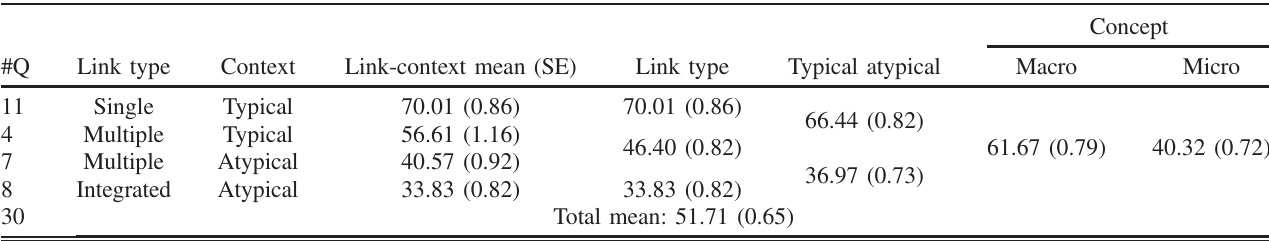
TABLE II. Mean percentage scores ( N ¼ 586 ) on question categories designed with different configurations in link-type, context, and conceptual models. The mean scores are in percentage scale with standard errors shown in